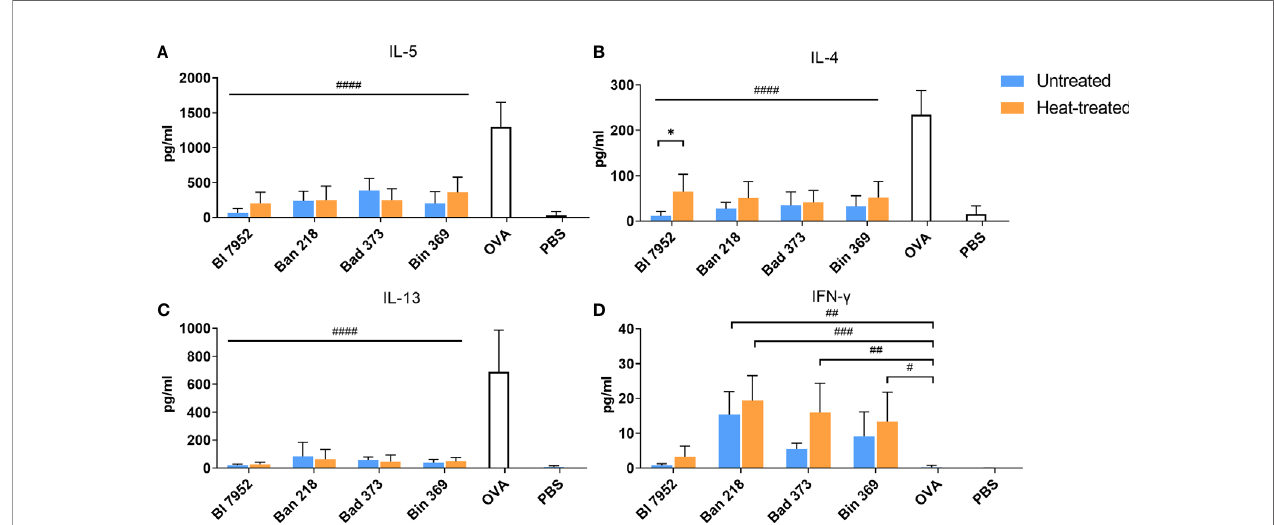
FIGURE 4 | Untreated and heat-treated bi fi dobacteria strains in fl uence the OVA-induced cytokine production in splenocyte cultures from OVA-sensitized mice. Effect of untreated (UN, blue bars) and heat-treated (HT, orange bars) bi fi dobacteria strains on cytokine production: (A) IL-5, (B) IL-4, (C) IL-13, and (D) IFN- g was measured in supernatants after 72 h cultivation of splenocytes isolated from OVA-sensitized mice and re-stimulated by OVA with or without bi fi dobacteria strains. Cells stimulated by PBS only served as negative control. Values are pooled from two independent experiments. Signi fi cant difference between UN and HT bacteria was estimated by unpaired Student ’ s t-test (*p <.0.05). Comparison between OVA-stimulated and bi fi dobacteria + OVA-stimulated groups was calculated by one- way ANOVA Dunett ’ s multiple comparison test. OVA group was used as control, # p < 0.05, ## p < 0.01, ### p < 0.001, #### p <